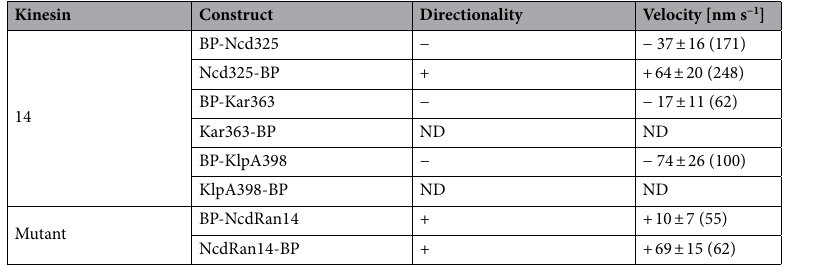
Table 2. Summary of direction and velocity of QD coated with monomeric kinesin-14s along a microtubule. The minus (−) and plus (+) sign refer to the minus-end-directed and plus-end-directed motility, respectively. In assays using either BP-Ncd325, Ncd325-BP, BP-Kar363, BP-KlpA398, BP-NcdRan14, or NcdRan14-BP, 26, 88, 18, 58, 9 and 19 QDs respectively moved in the indicated direction (+ or −) along polarity-marked microtubules with no exceptions. Only QDs that moved more than ~ 0.25 µm were analysed. Velocity data includes the QD movement along both polarity-marked and non-polarity-marked microtubules and is given as mean ± SD. n , number of QDs. ND, not determined. QDs coated with either multiple Kar363-BP or KlpA398-BP molecules did not show unidirectional processive movement of more than 0.25